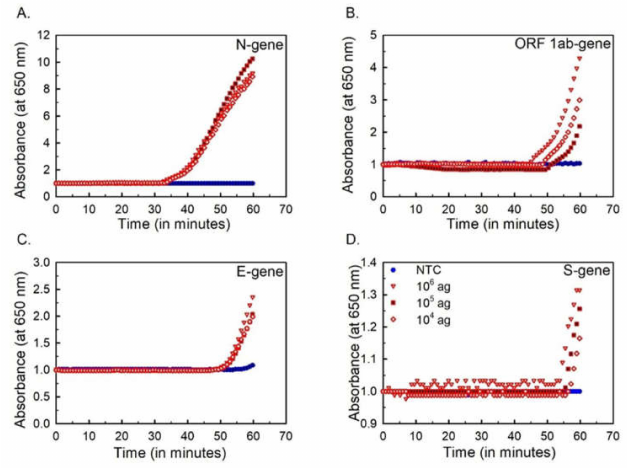
Figure 1. Sensitivity of RT-LAMP assay. Amplification curves for in vitro transcribed RNA (10 6 ag µ L − 1 , 10 5 ag µ L − 1 , and 10 4 ag µ L − 1 ) between the absorbance at wavelength 650 nm and time of amplification.